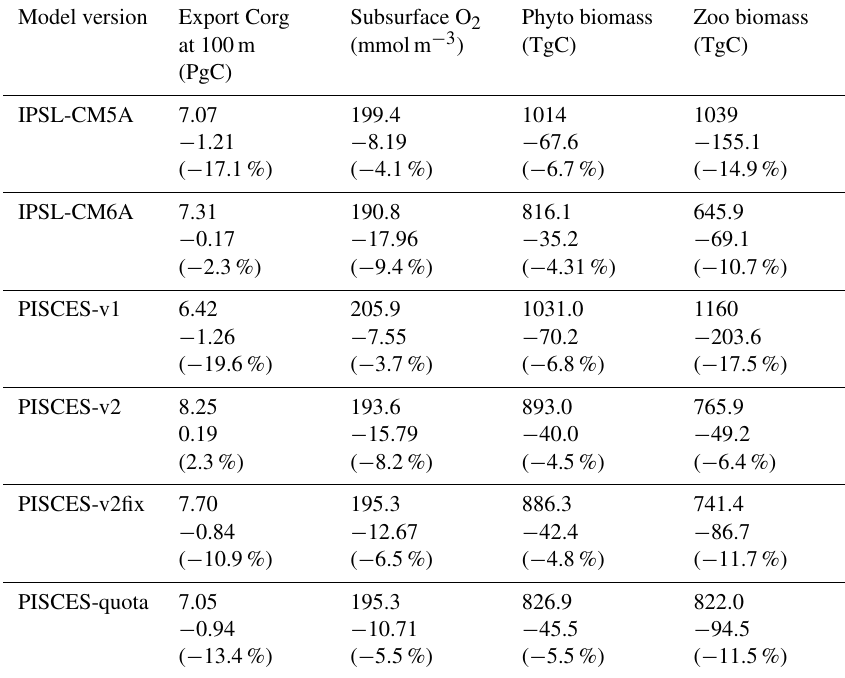
Table 3. Impact of climate change on organic matter export at 100m, subsurface (100–600m) oxygen concentrations, and phytoplank- ton (“Phyto”) and zooplankton (“Zoo”) biomass in the different model versions. All columns indicate absolute values for 1986–2005 and differences between 2080–2099 and 1986–2005 (relative values in